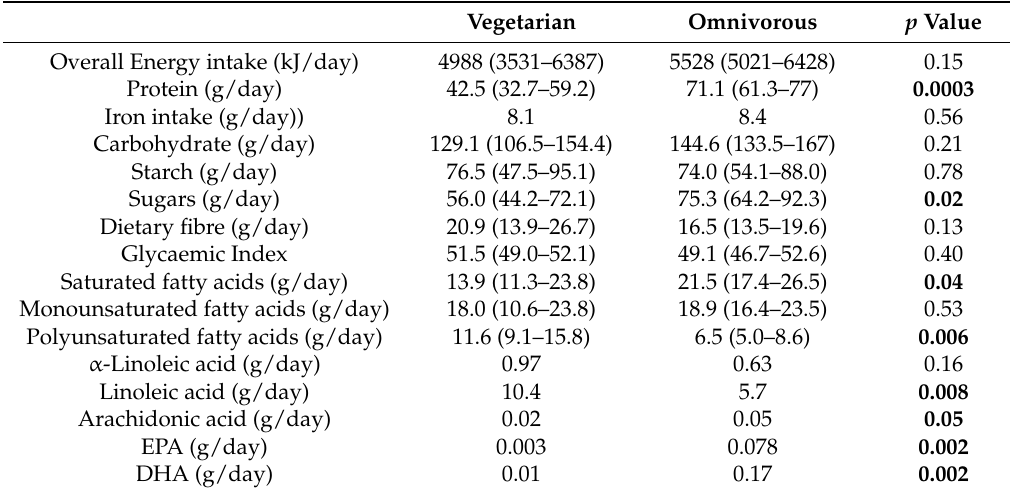
Table 2. Dietary